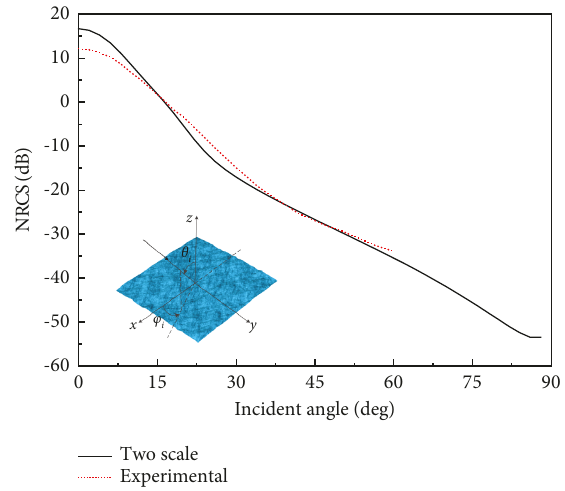
Figure 5: The normalized backscattering results of the two